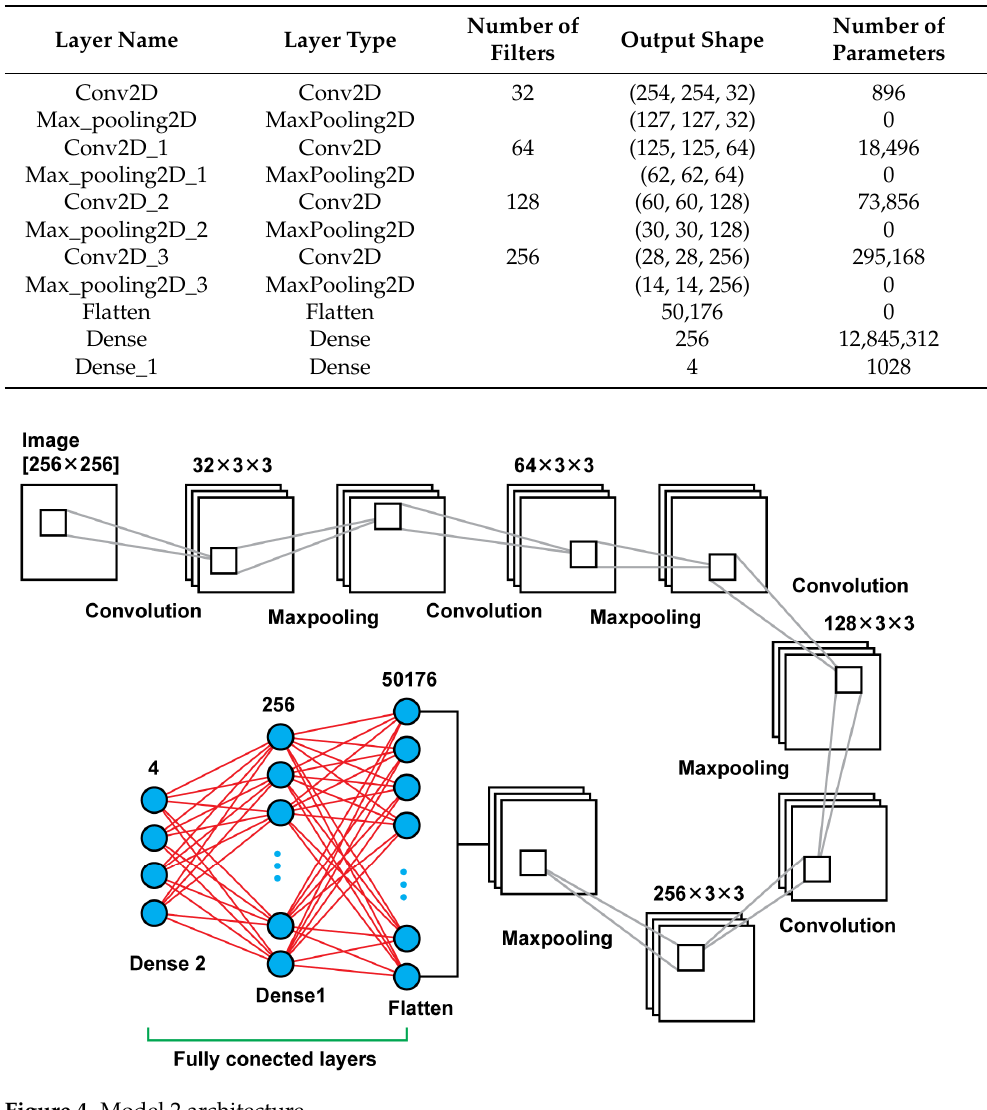
Figure 4. Model 2 architecture.